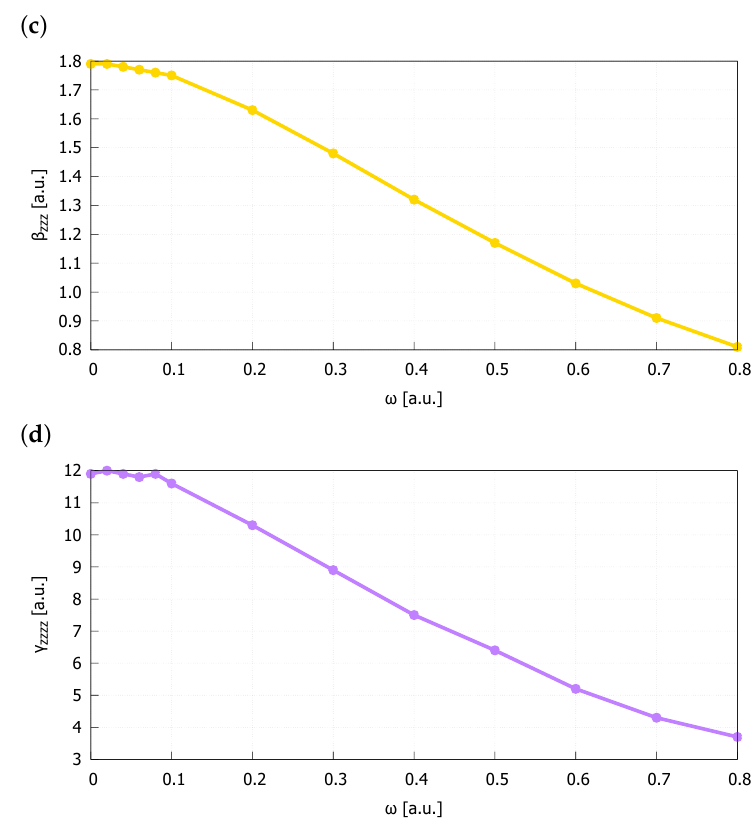
Figure 2. ( a ) Dipole moment ( µ z ), ( b ) polarizability ( α zz ), ( c ) first hyperpolarizability ( β zzz ) and ( d ) second hyperpolarizability ( γ zzzz ) of HeH + embedded in cylindrically symmetric harmonic oscillator potential of ω strength obtained at the CCSD/aug-cc-pV6Z level of